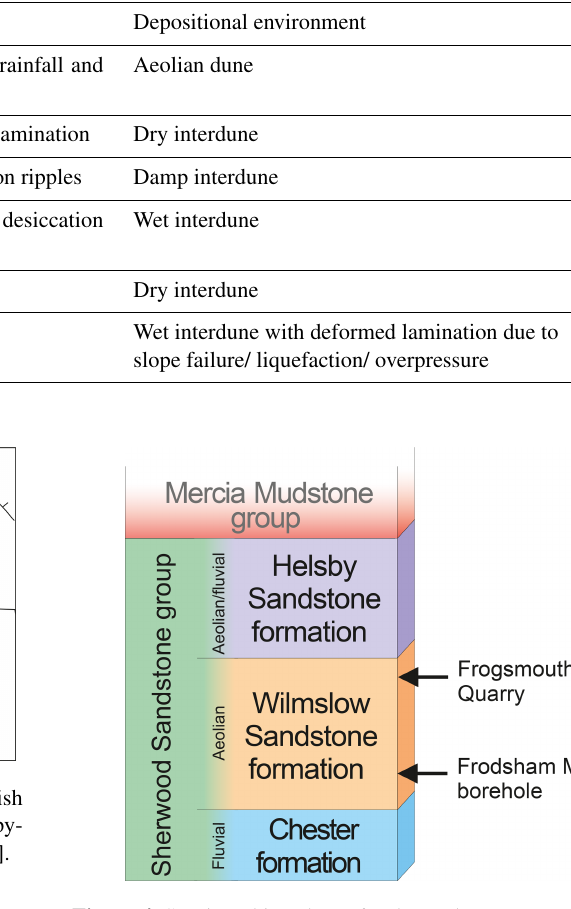
Figure 4. Stratigraphic column for the study